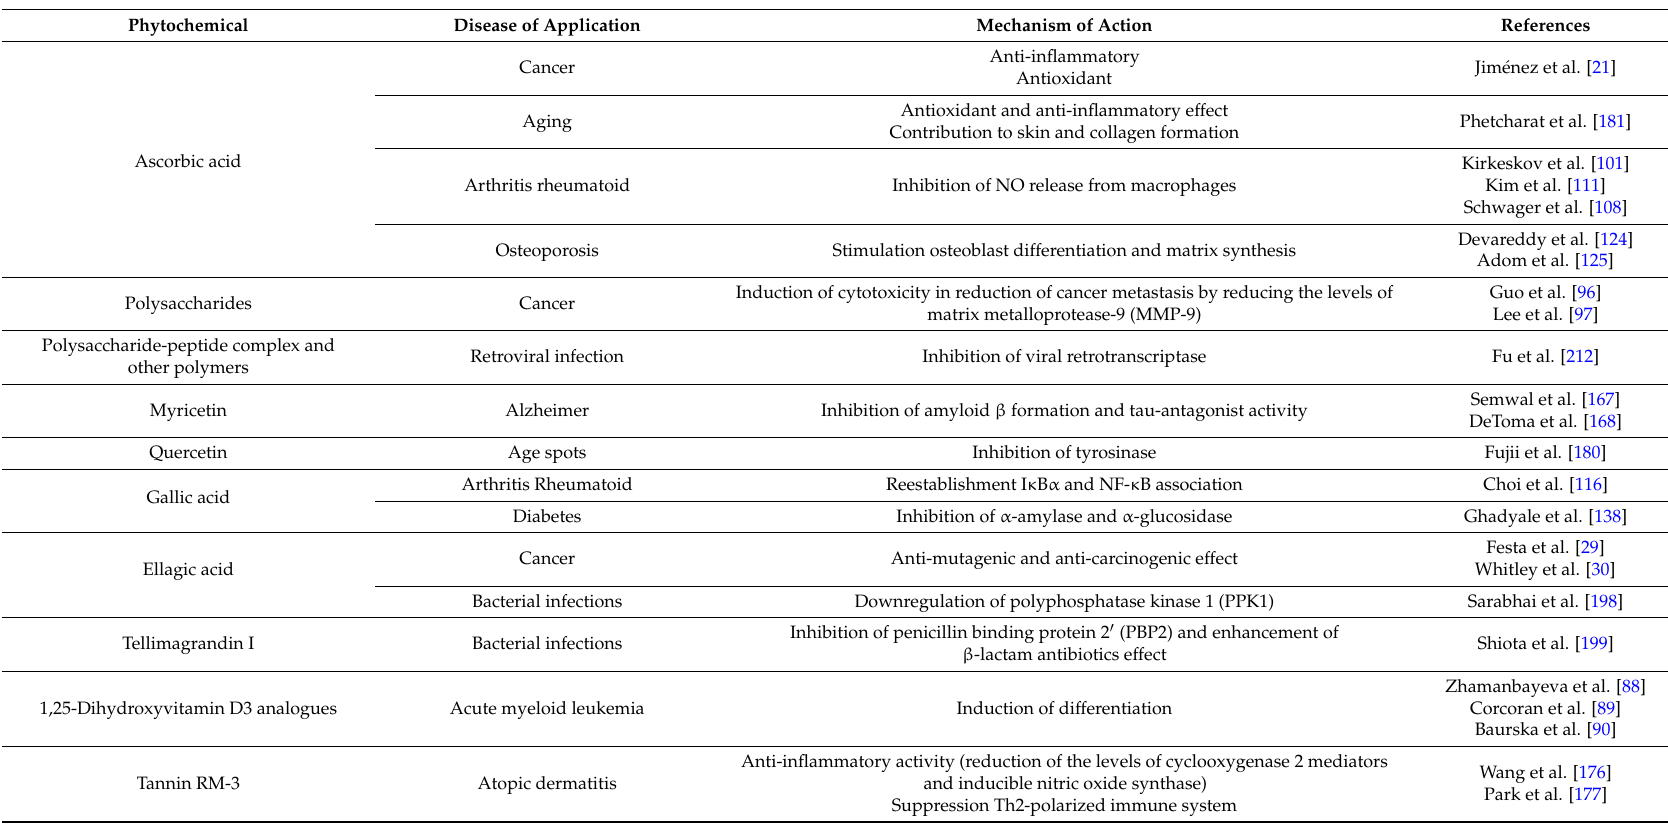
Table 9. Main active compounds of Rosa spp. extracts and their application in human